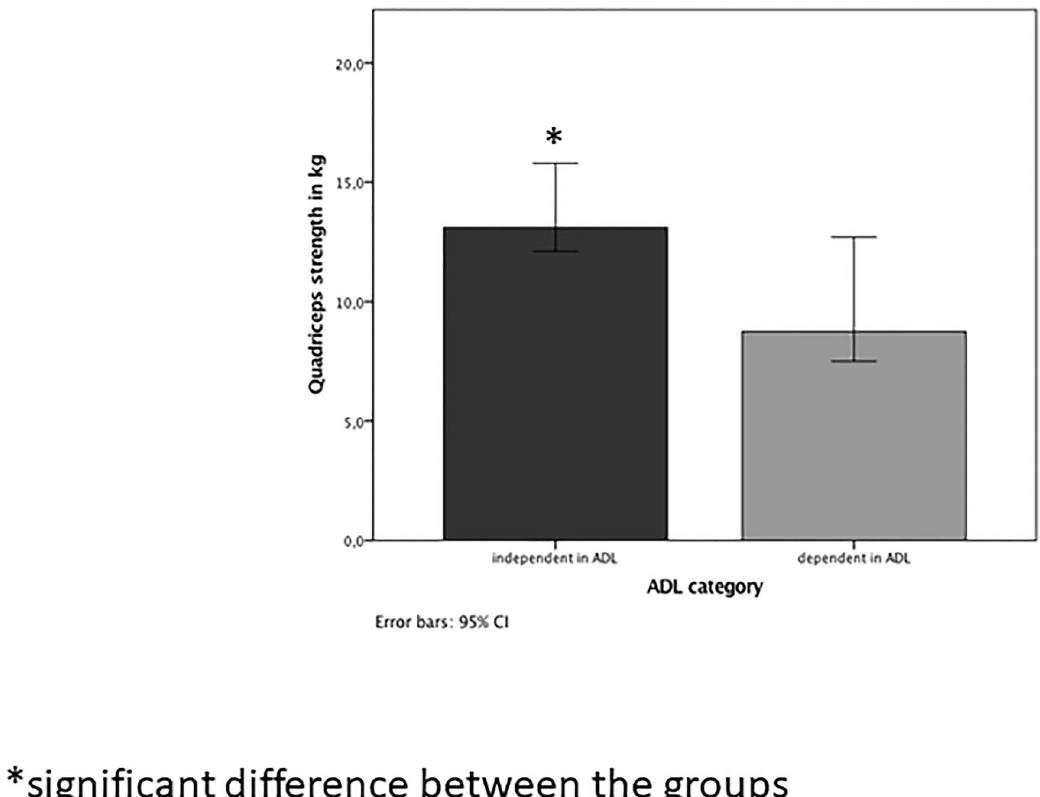
Fig 1. Quadriceps strength in people independent and dependent in